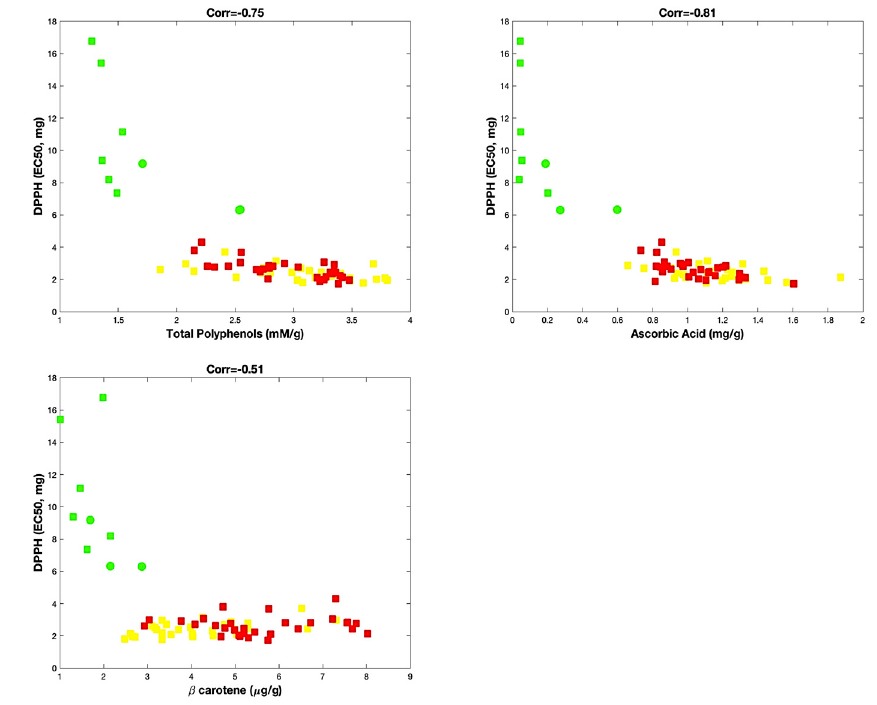
Figure 2. Correlation analysis. Red and yellow varieties are indicated with red and yellow squares, respectively. Green varieties are represented with green squares, except samples of “Friariello Nocerese”, represented by green circles, to highlight that at least two (of three samples) resulted very similar to red and yellow samples.